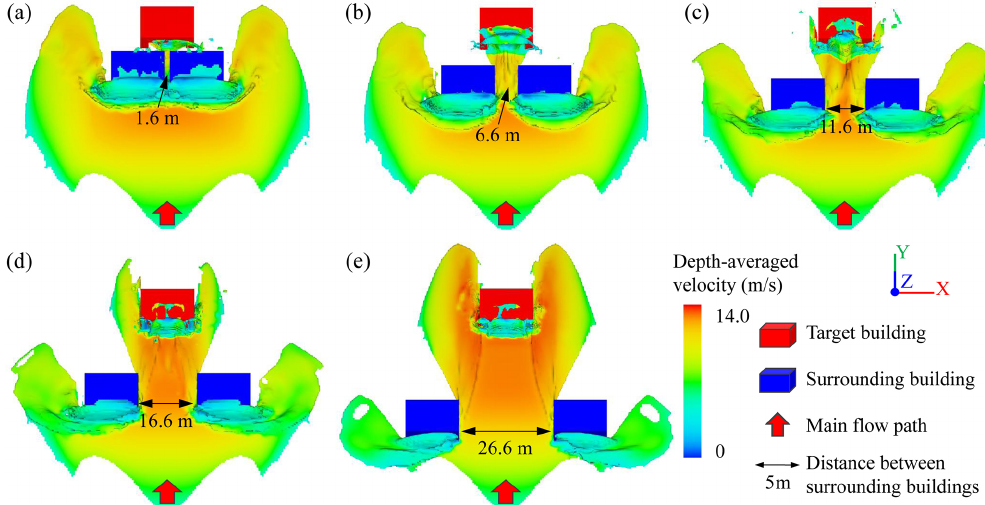
Figure 13. Snapshots for debris flow intensities in the scenarios of Or90-Op0.4- A 30- Dx at a simulation time of 8.0s. Panel (a) is the case of Or90-Op0.4- A 30- D 5, (b) is the case of Or90-Op0.4- A 30- D 10, (c) is the case of Or90-Op0.4- A 30- D 15, (d) is the case of Or90-Op0.4- A 30- D 20 and (e) is the case of Or90-Op0.4- A 30- D